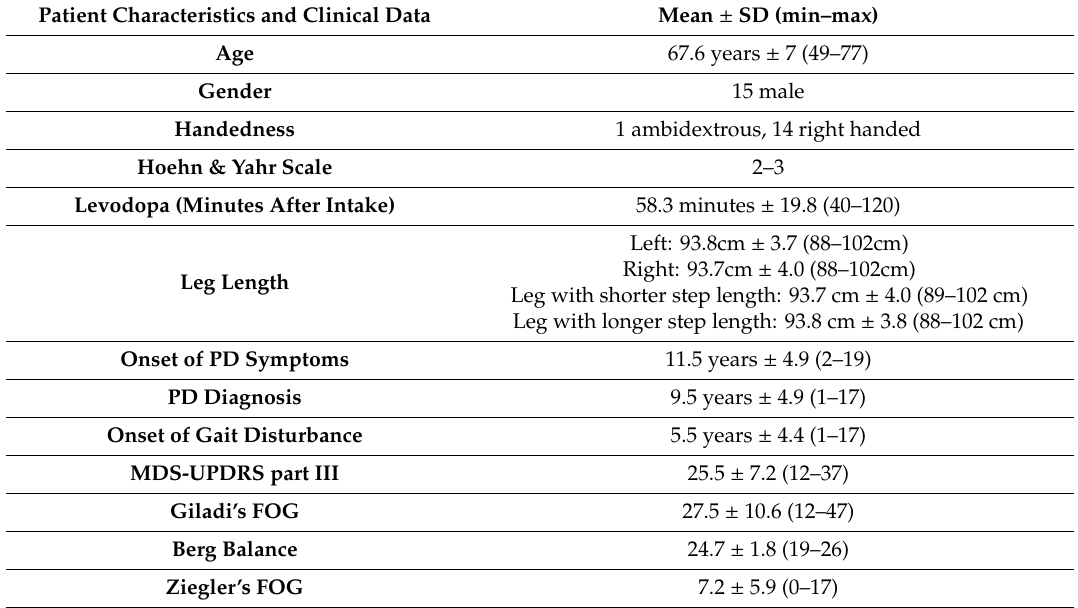
Table 1. Patient characteristics, clinical data, and